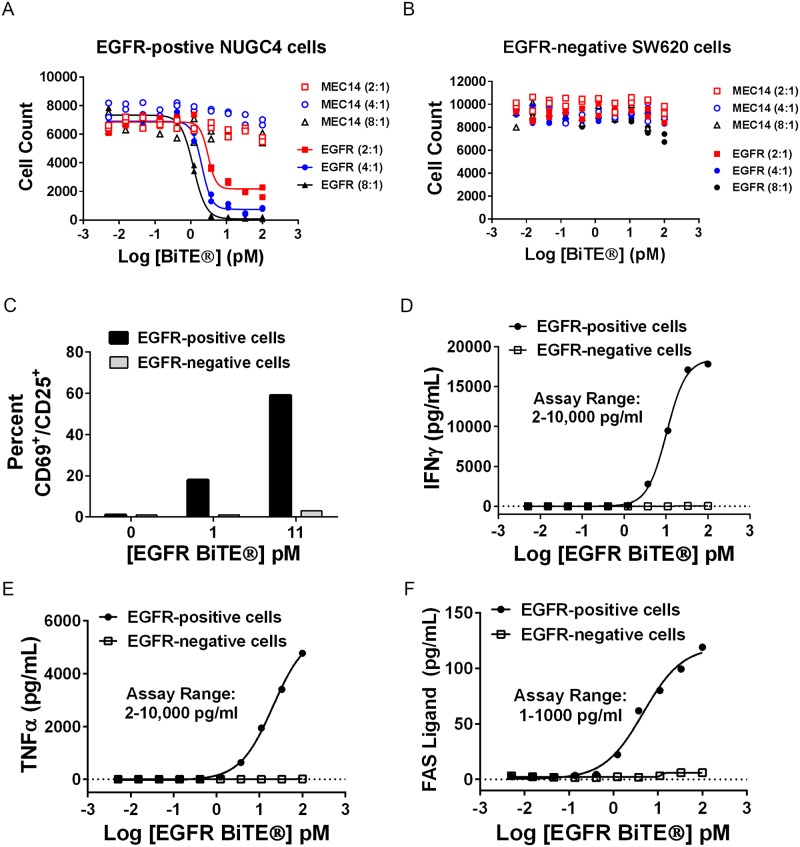
T cells were activated by EGFR BiTE® in the presence of EGFR-expressing cells.(A) NUGC4 (EGFR-positive) or (B) SW620 (EGFR-negative) cells were incubated for 40 hours with EGFR BiTE® or MEC14 negative control BiTE® at E:T ratios of 2:1, 4:1 and 8:1. Cytotoxicity was measured by nuclear count with cellular imaging (N = 2, all data points shown). (C-F) Target cells, T cells (E:T ratio 7:1) and EGFR BiTE® were incubated for 48 hours. Supernatants from 4 replicate wells were combined for each data point prior to separating T cells and media. (C) Percent CD69+/CD25+ cells was determined by flow cytometry. (D-F) Cytokine concentrations were determined by commercially available ELISA or MSD assays. Data shown for T cell activation and cytokine release are representative assays that were repeated at least twice.